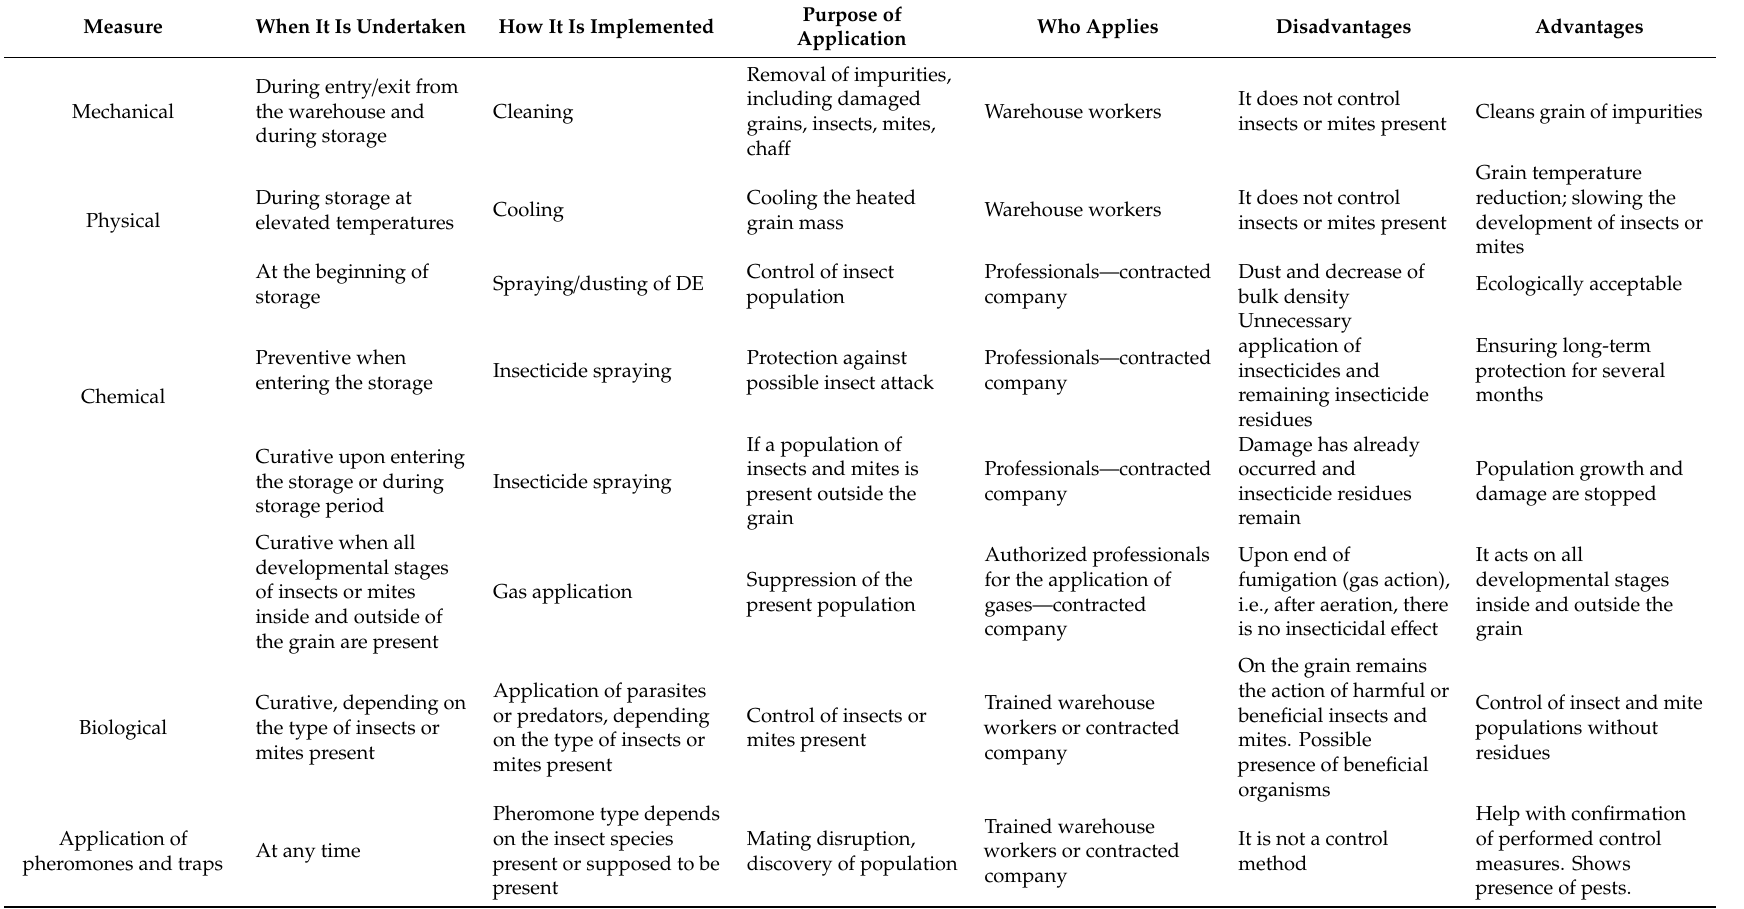
Table 2. Measures applied in storehouses containing